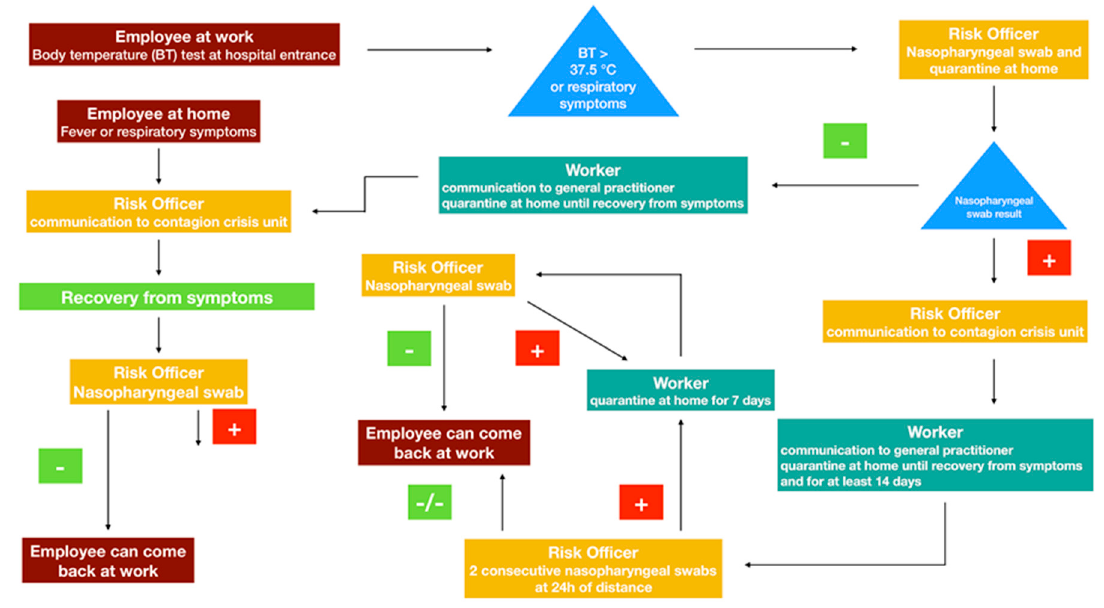
Figure 3. The flow chart describes the oncologic hub staff management during COVID-19